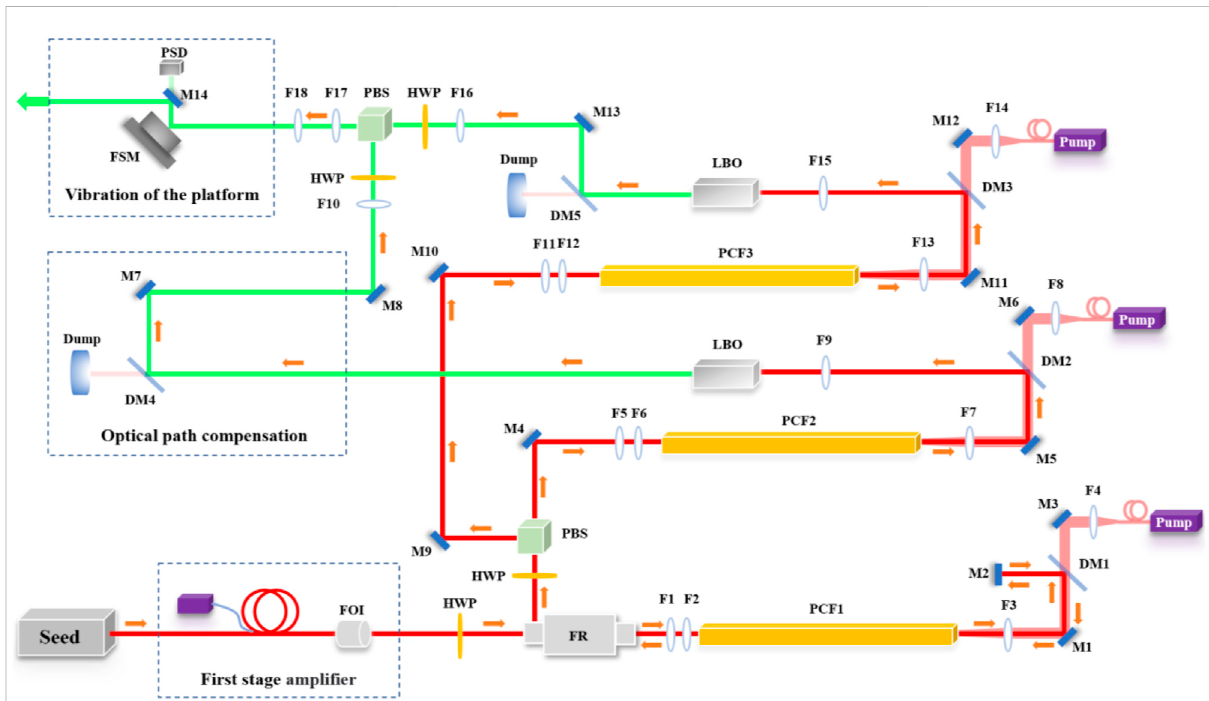
FIGURE 1 Schematic showing the layout of the laser system. FOI, fi ber optic isolator; HWP, half-wave plate; FR, Faraday rotator; M, mirrors; F, focus lens; PBS, polarizing beam splitter. FSM, fast steering mirror; PSD, position sensitive